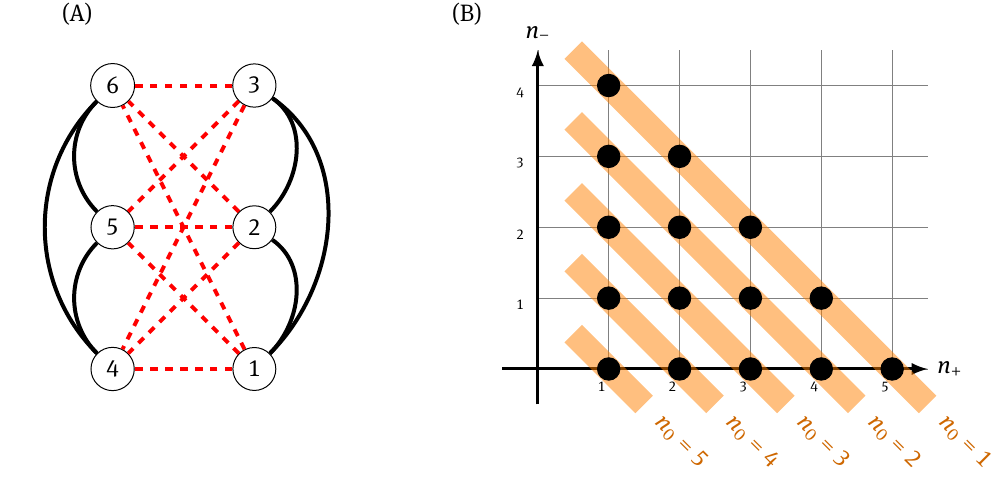
Figure 7: (A) The graph K 3 ∨ − K 3 . (B) The lattice representing all possible Laplacian inertias for K 3 ∨ − K 3 .